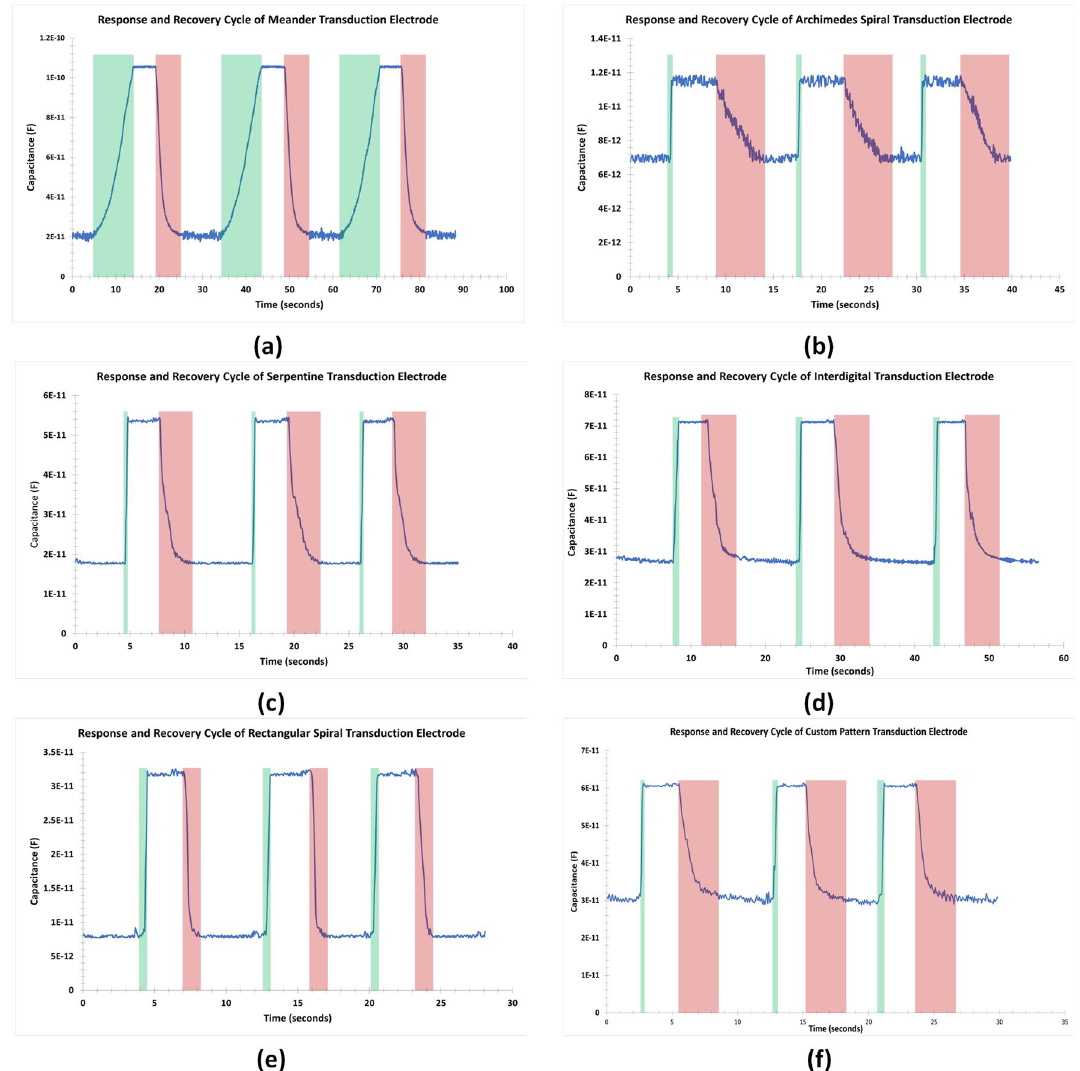
Figure 7. Response and Recovery cycle of patterned sensors for ( a ) Meander, ( b ) Archimedes spiral, ( c ) Serpentine, ( d ) Interdigital, ( e ) Rectangular spiral, and ( f ) Custom design.